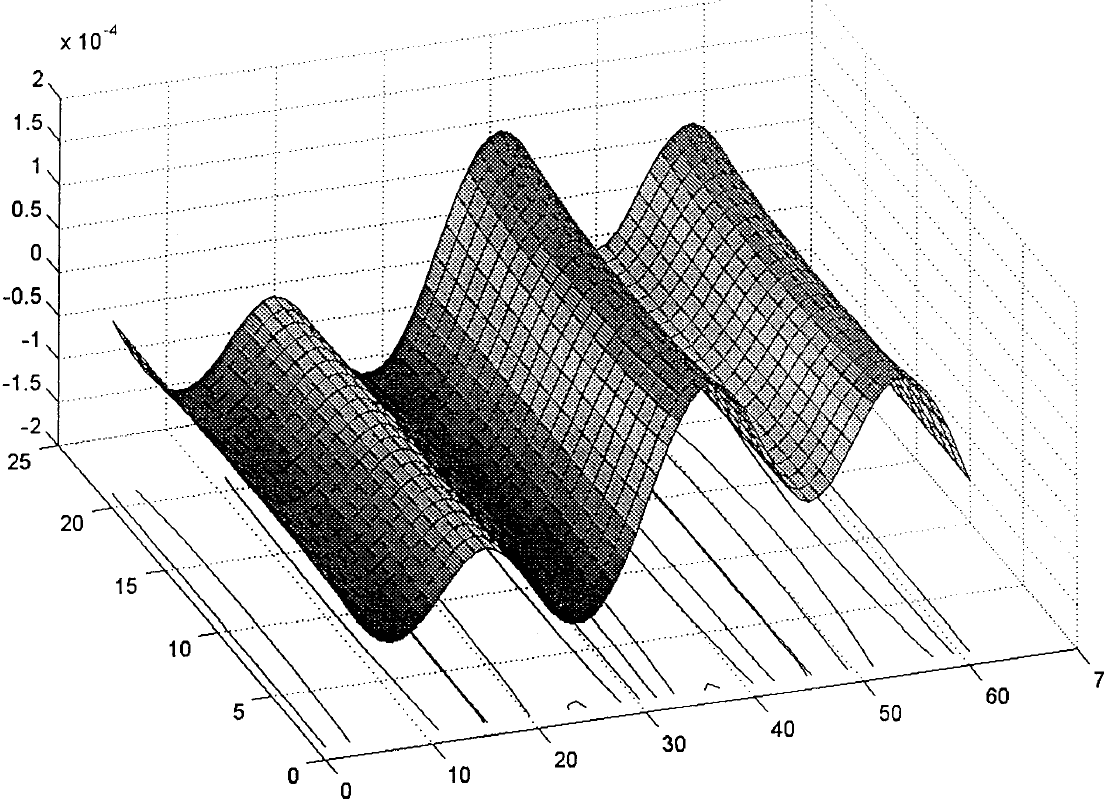
Fig. 11. Third mode shape of 4-span deck, φ 1 = φ 3 = φ 4 = 1 . 0 , φ 2 = 1 . 1